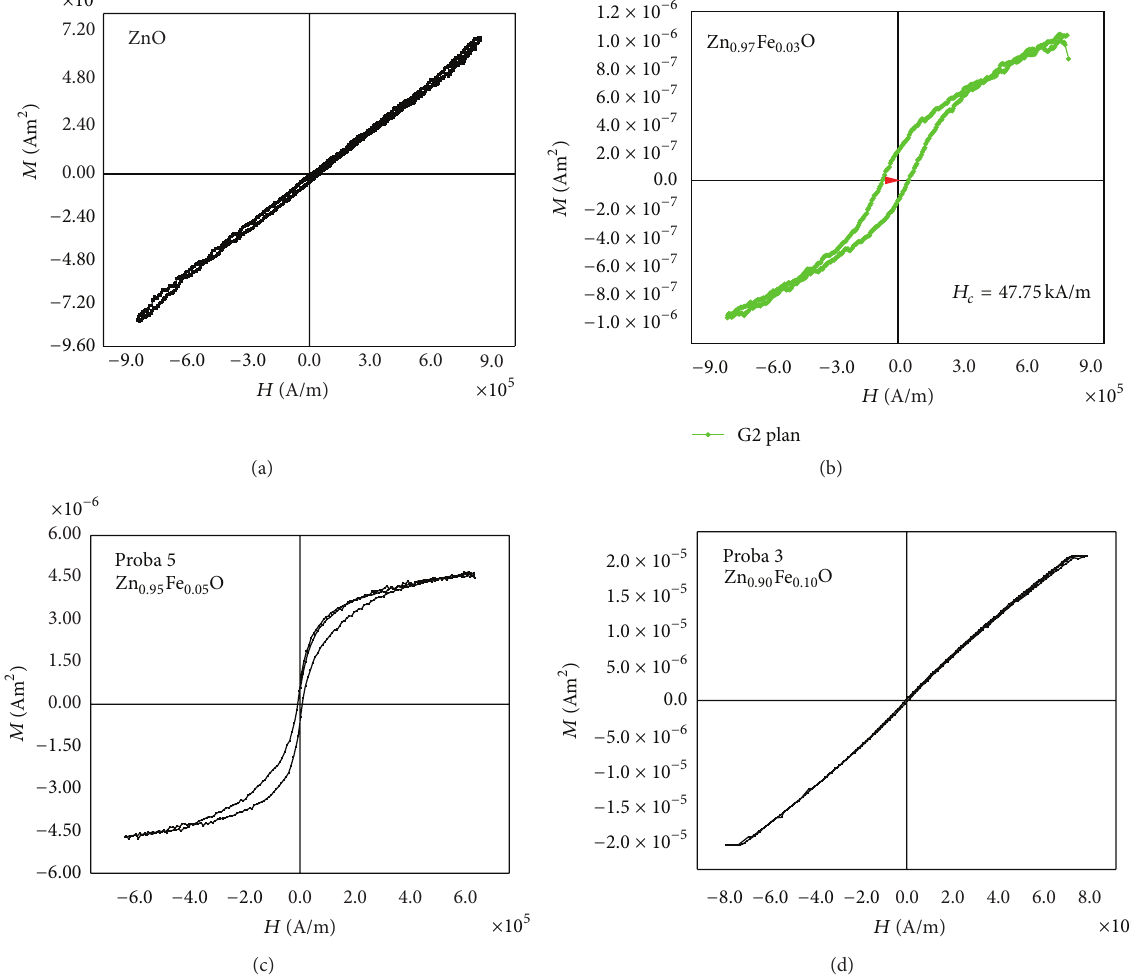
Figure 6: Magnetic hysteresis curves of (a) ZnO, (b) Zn 0.97 Fe 0.03 O, (c) Zn 0.95 Fe 0.05 O, and (d) Zn 0.90 Fe 0.10 O thin